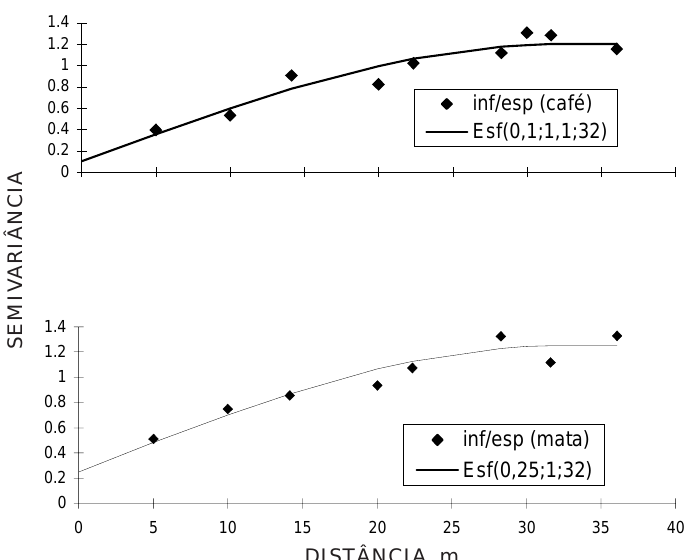
Figura 5. Semivariograma cruzado da infiltração de água no horizonte A e da sua espessura, nos cultivos de café e na